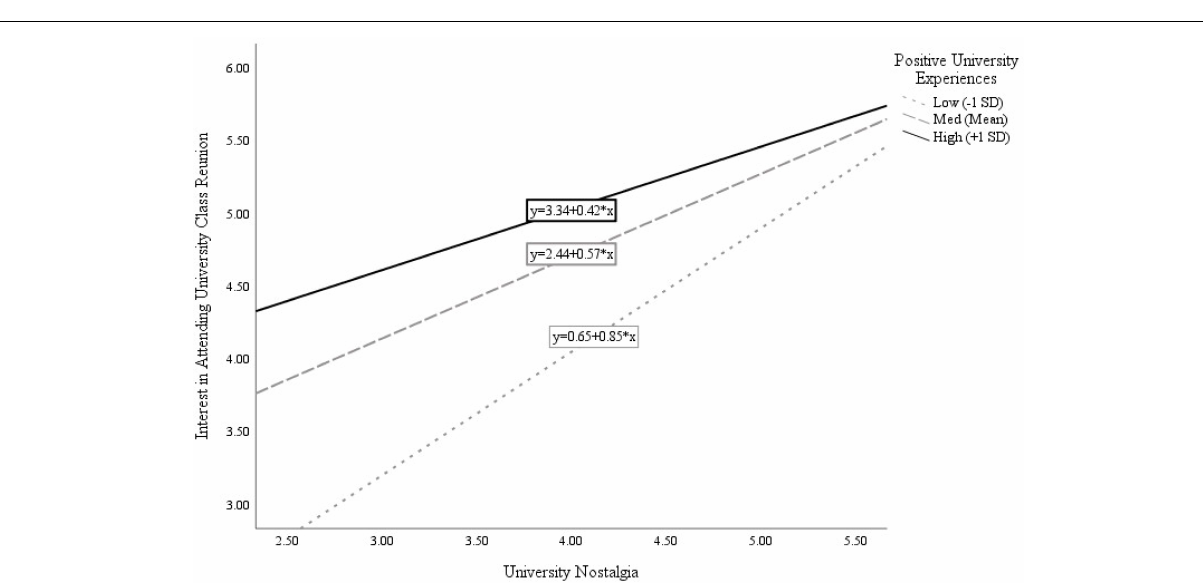
FIGURE 1 | Moderation of relation between University Nostalgia and charitable donations positivity of University experiences.